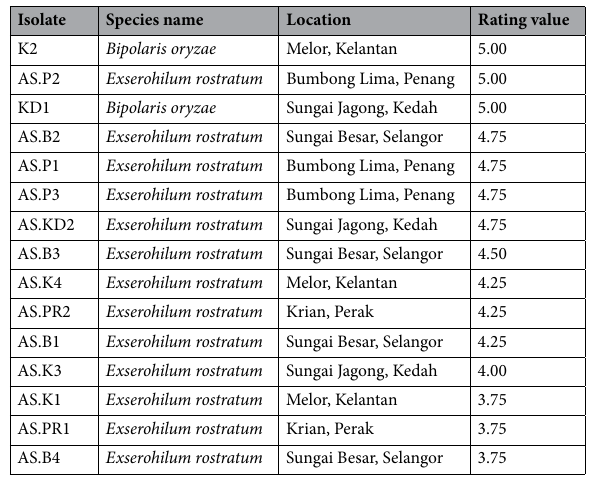
Table 2. Rating scores of rice brown spot fungal isolates, as determined using the leaf detach